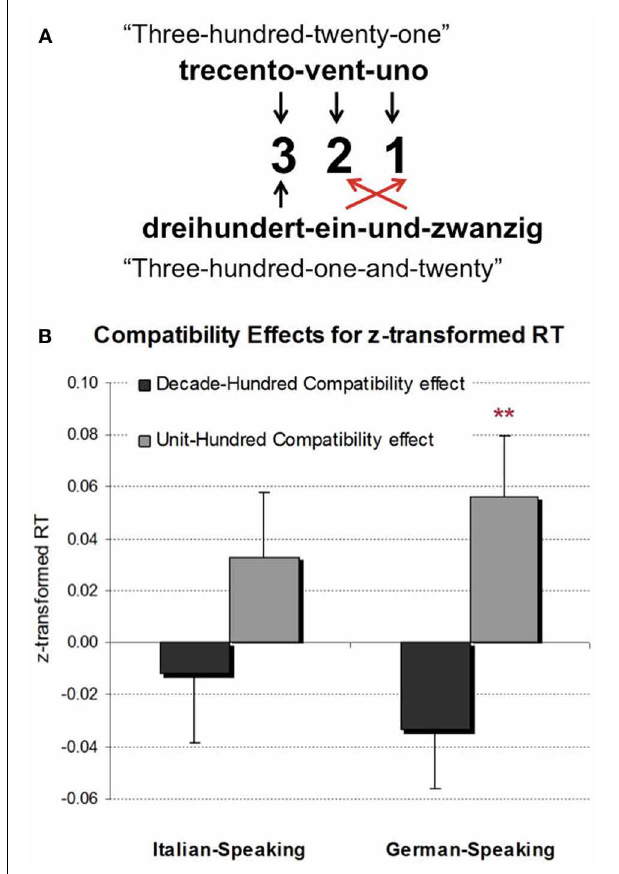
FIGURE 1 | (A) Inversion property: The units digit is named right after the hundreds digit in German while it is named last corresponding to its position in digital notation in Italian. (B) Decade-hundred compatibility effects and unit-hundred compatibility effects (RT incompatible—RT compatible items in both cases) for Italian- and German-speaking 3rd graders. German-speaking 3rd graders’ performance was significantly influenced by the interfering units while this was not the case for Italians. ∗∗ p < 0 .